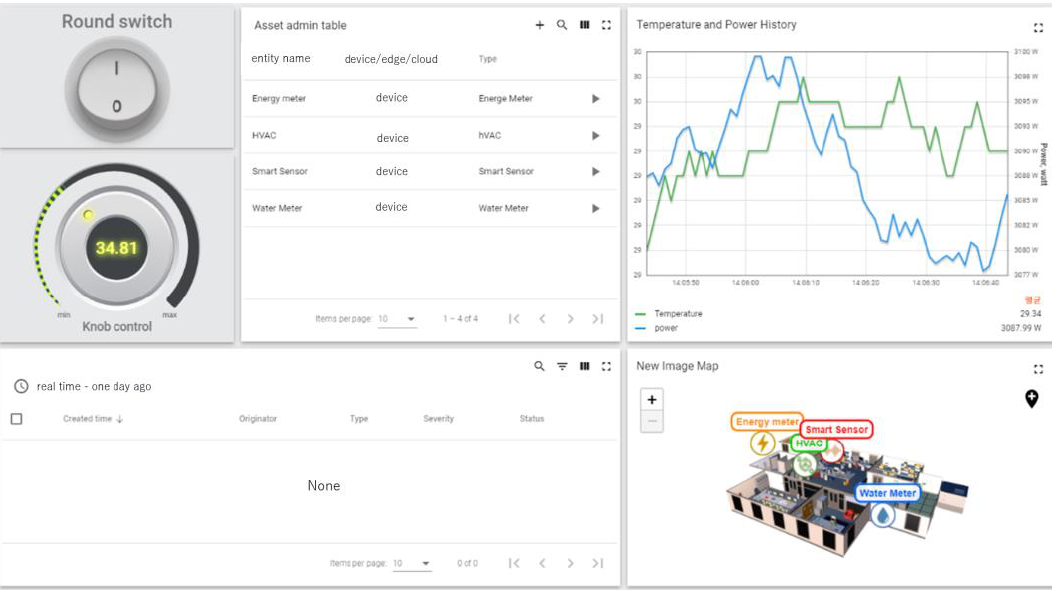
Figure 10. First dashboard screen captured. (For your information, In this figure, the non-English term “ 평균 ” means “ average ” in English) .